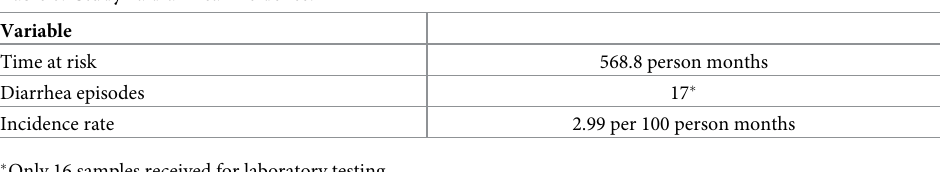
Table 6. Study 2a diarrheal incidence.